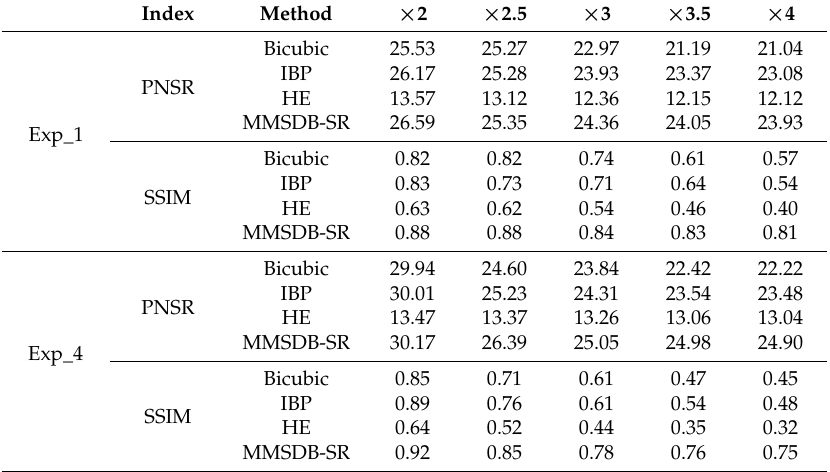
Table 4. Objective evaluation indexes of different-scale reconstruction results.